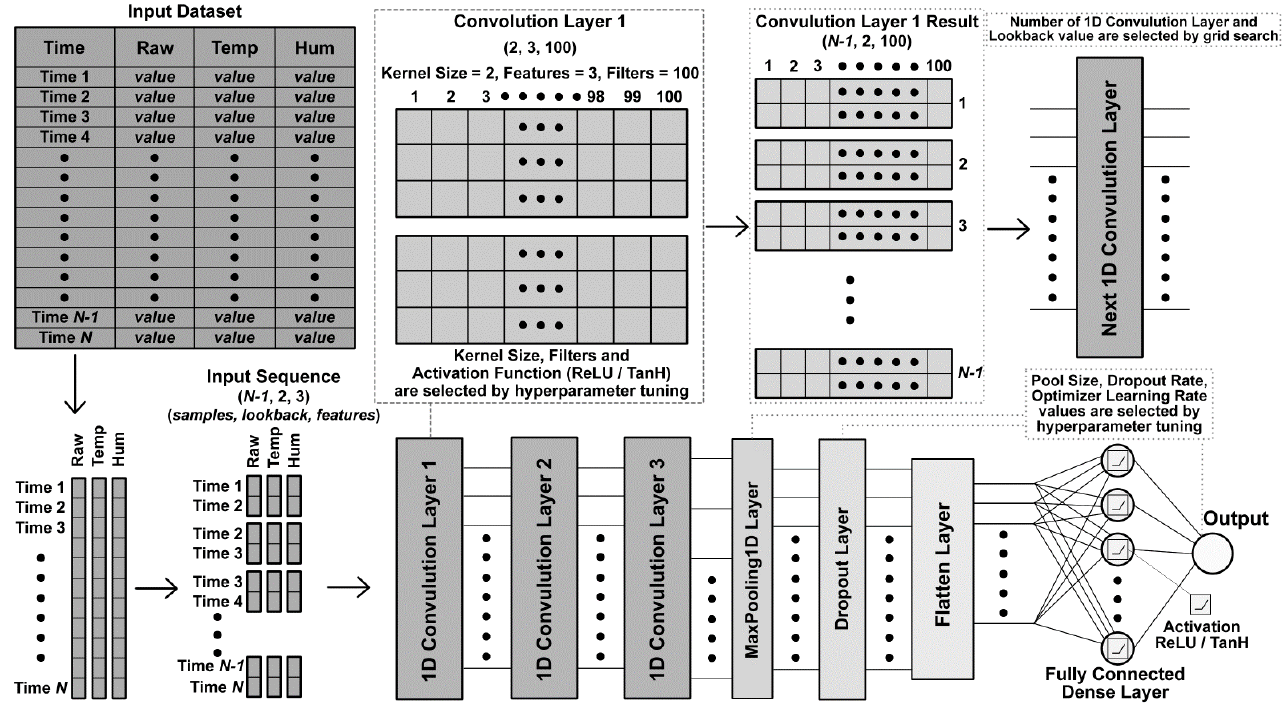
Figure 2. An example of a 1DCNN model developed for this study. Please note that many parameters are determined through grid search and tuning. Therefore, they vary depending on the data set, scenario (input variables used), and time split.